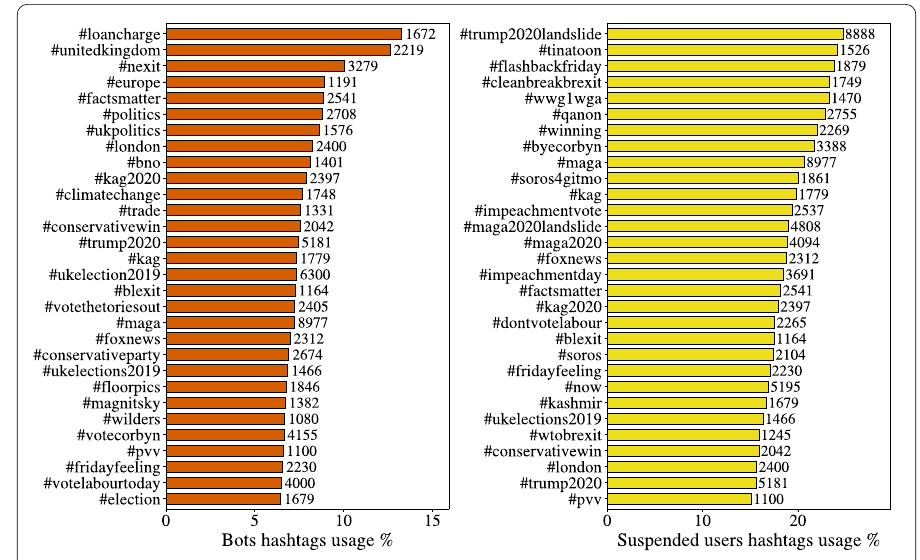
Figure 6 Most retweeted hashtags by bots and suspended users in percentage. The percentages are calculated over all users’ hashtags’ usage. The numbers on the right side of the bars represent the total number of retweets of posts (by all users) containing the corresponding hashtag